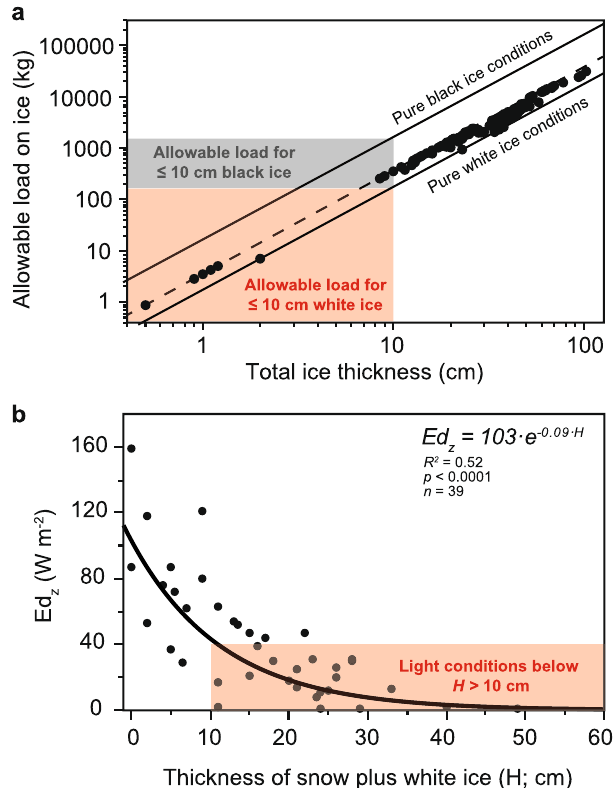
Fig. 3 | Lake ice conditions that are critical for ice stability and for the trans- mittance of photosynthetically active radiation. a Variation in the estimated allowableloadonicedependingontotalicethicknessandicequality.Pureblackice conditions were modeled using Eq. (1) with A =30kgcm − 2 and pure white ice conditions using Eq. (2) with A =3.5kgcm − 2 . The dashed line represents estimates of the allowable load using Eq. (1) with A =3.5kgcm − 2 , which is commonly used for icesafetyguidelines.BlackdotsshowestimatesfortheIceBlitzdatasetusingEq.(2) with A =3.5kgcm − 2 . The red and gray shaded areas mark the allowable load for an icethicknessof 10cmandless underpurewhite ice(red)andpureblackice (gray) conditions. b Dailymean(8.00a.m.to8.00p.m.)under-iceirradiance( Ed z )inWatts (W) m − 2 in Lake Vendyurskoe during spring just before ice-off in relation to the thickness of snow and white ice ( H ) on the lake. Data were taken from Zdor- ovennovaetal. 36 ,measuredduring1997 – 2020.Shownistheexponentialdeclineof Ed z with increasing H (black line). The red shaded area marks the light availability below a 10cm thick snow and white ice layer on a